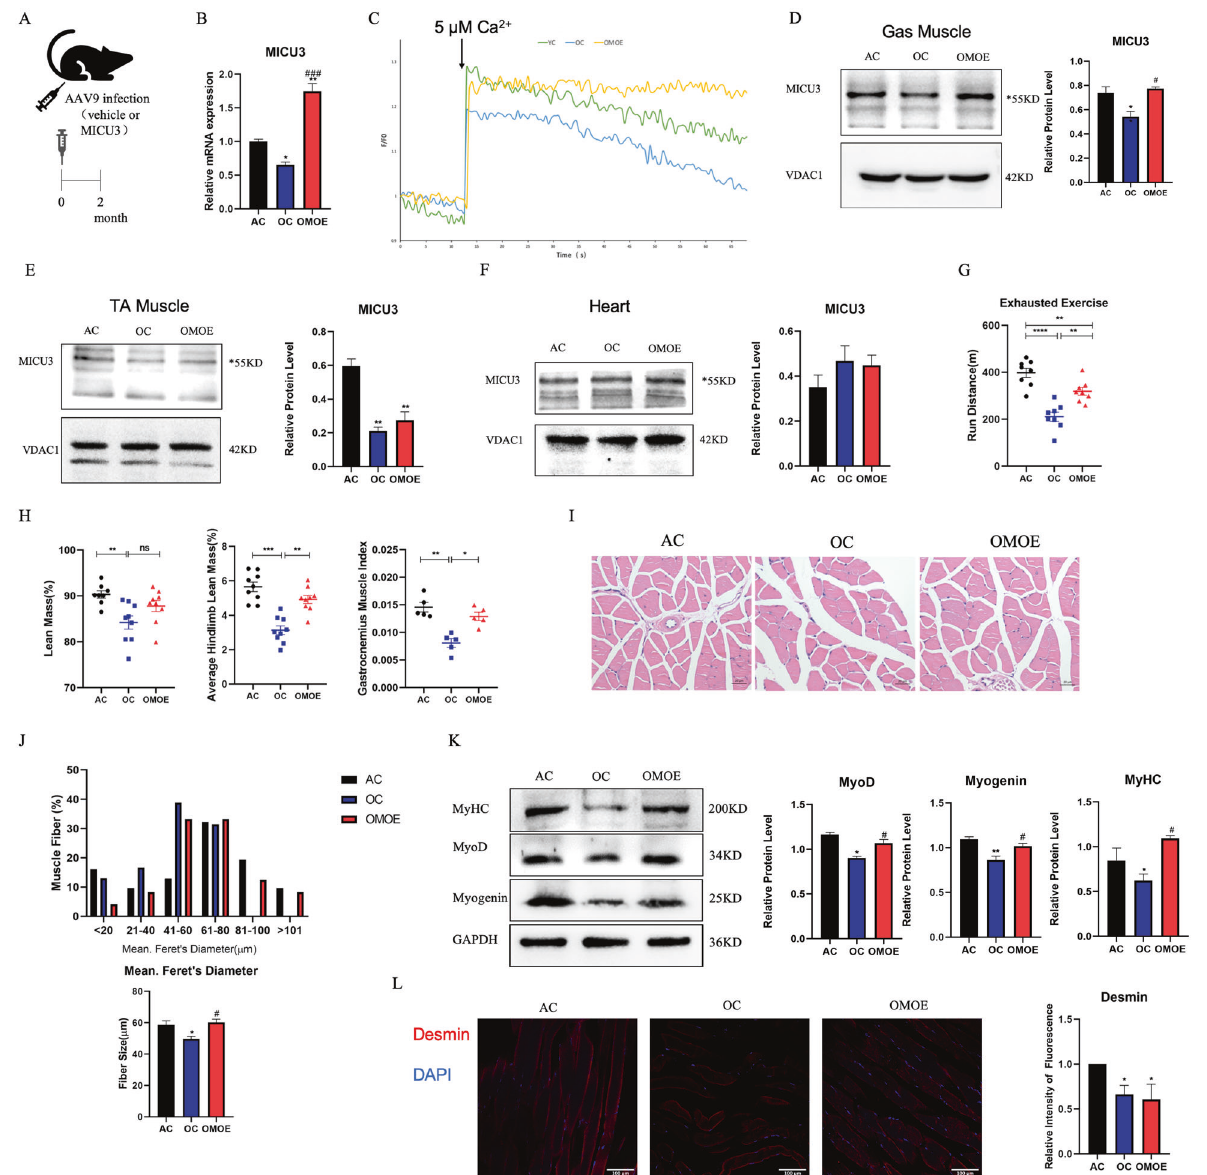
muscle. D – F Western blot and quanti fi cation for MICU3 in mice gastrocnemius muscle, tibialis anterior (TA) muscle, and myocardium. VDAC was used as the loading control. *indicates target bands. G The furthest running distance in exhausted exercise. H Lean mass (%), de fi ned